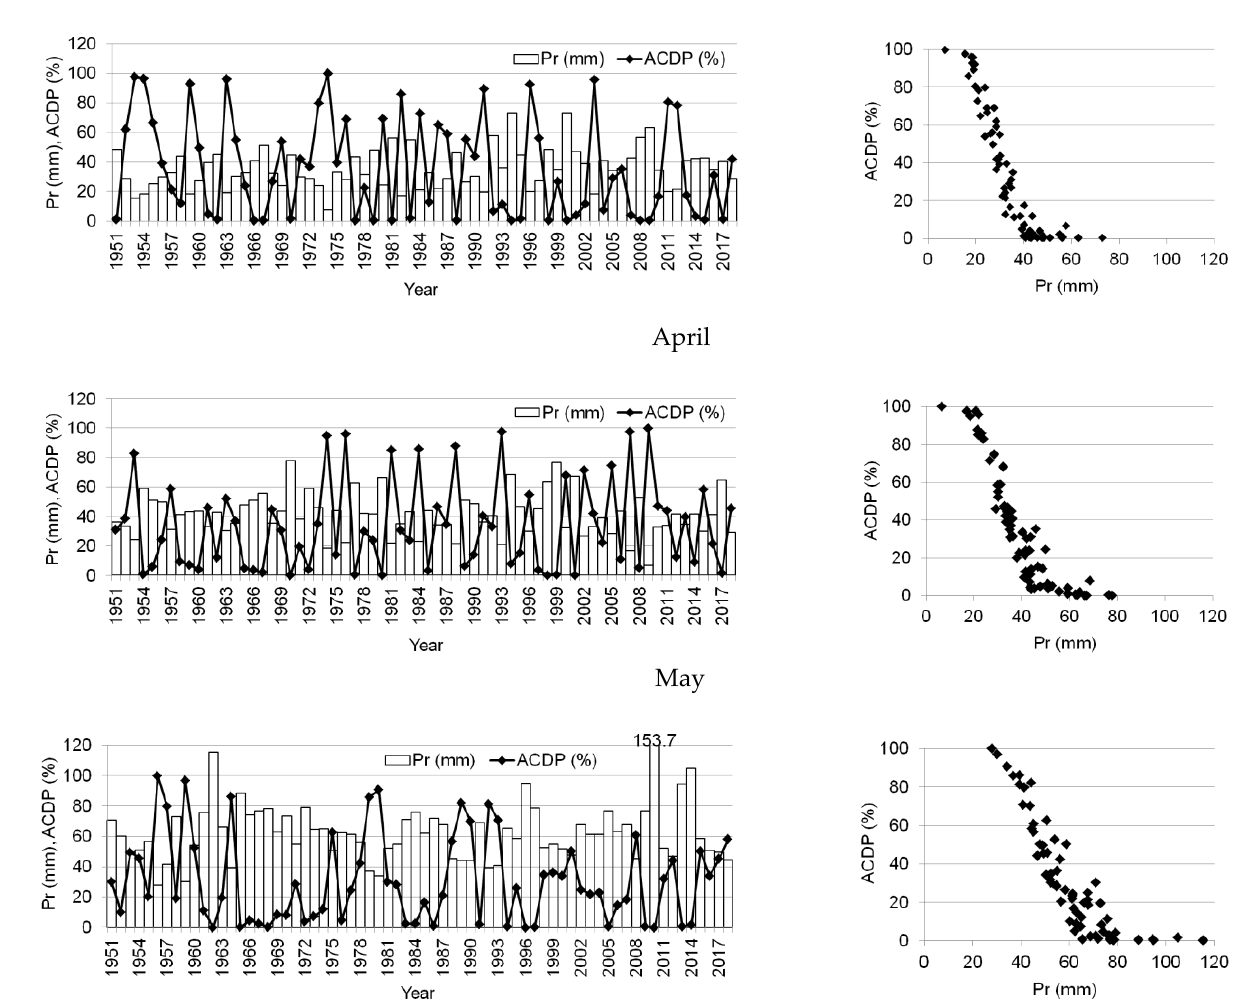
Figure 8. The changing areas of Poland affected by deficient precipitation (ACDP) against the variability of monthly area precipitation (Pr) in Poland (the left side of the figure), and the dependence of ACDP from Pr (the right side of the figure). Years 1951 – 2018.